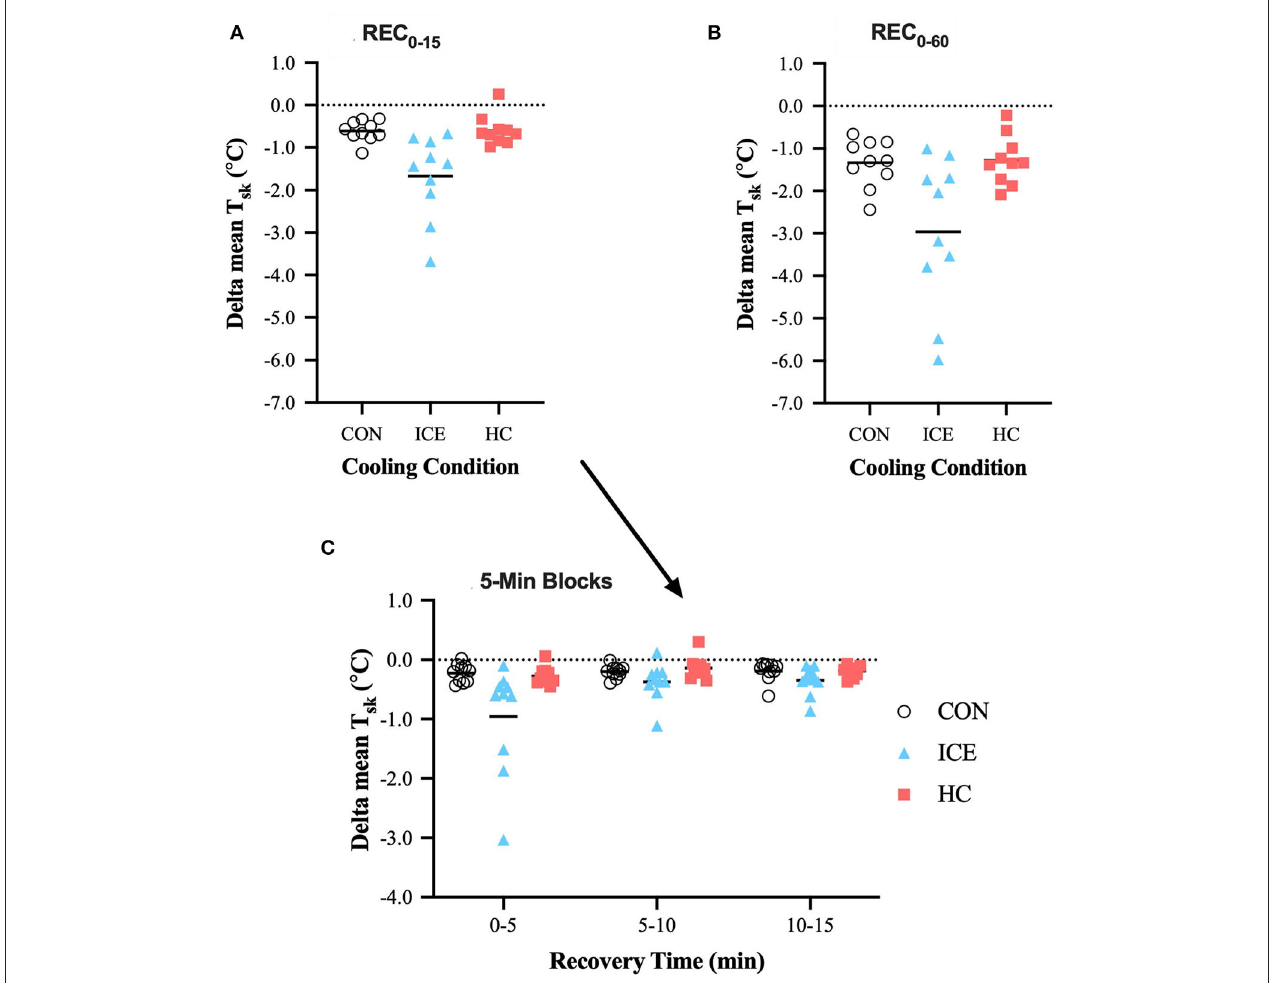
FIGURE 3 | Mean (bar) and individual delta mean skin temperature (T sk ) during REC 0 − 15 (A) , REC 0 − 60 (B) , and 5-min blocks during REC 0 − 15 (C) when using ice vest (ICE), single-hand cooling (HC), and non-cooled control (CON) during heated exercise